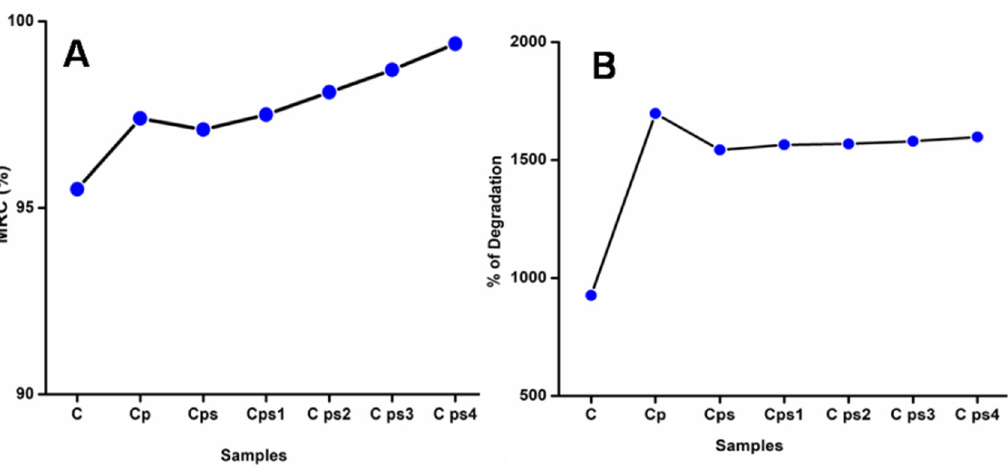
Figure 7. ( A ) Moisture retention capability of CH scaffolds ( B ) Degradation of CH scaffolds in Hank’s solution comprisinginorganic ions and glucose.